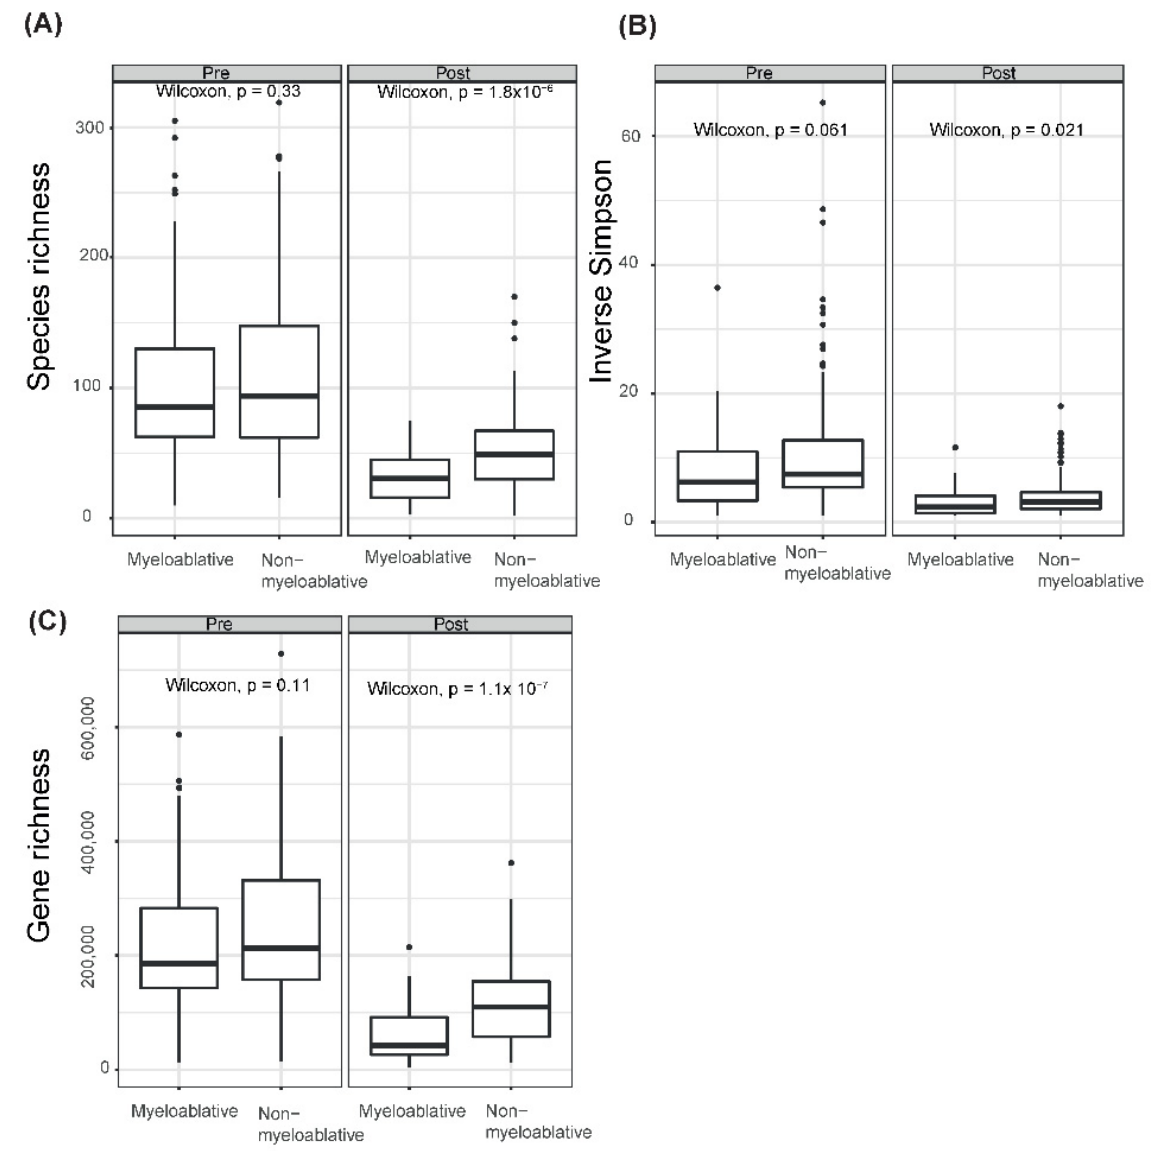
Figure 1. Gut microbiome diversity and associations with conditioning regimens. Boxplots of gut microbial diversity (( A ) species richness, ( B ) alpha diversity and ( C ) gene richness) in patients undergoing myeloablative conditioning vs. non-myeloablative conditioning in the pre-aHSCT and post-aHSCT samples. Wilcoxon tests were performed per diversity measure and period.